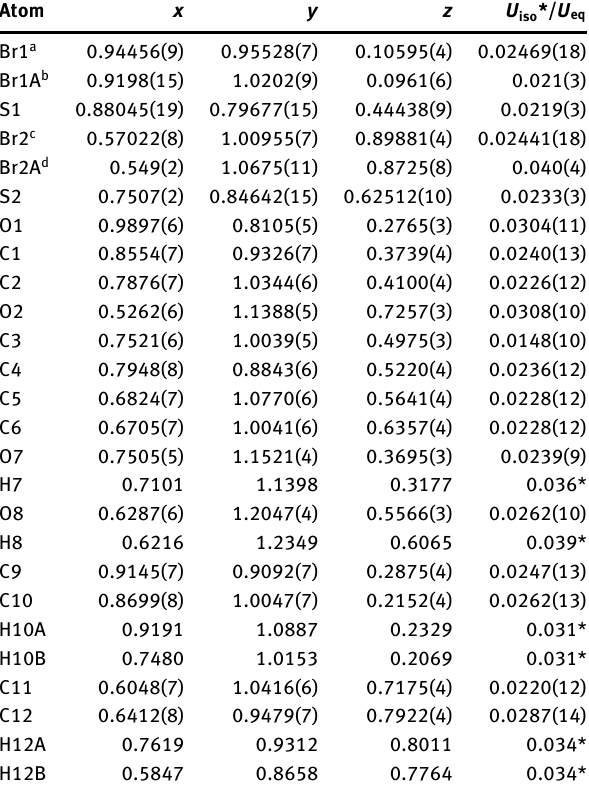
Table 2: Fractional atomic coordinates and isotropic or equivalent isotropic displacement parameters (Å 2